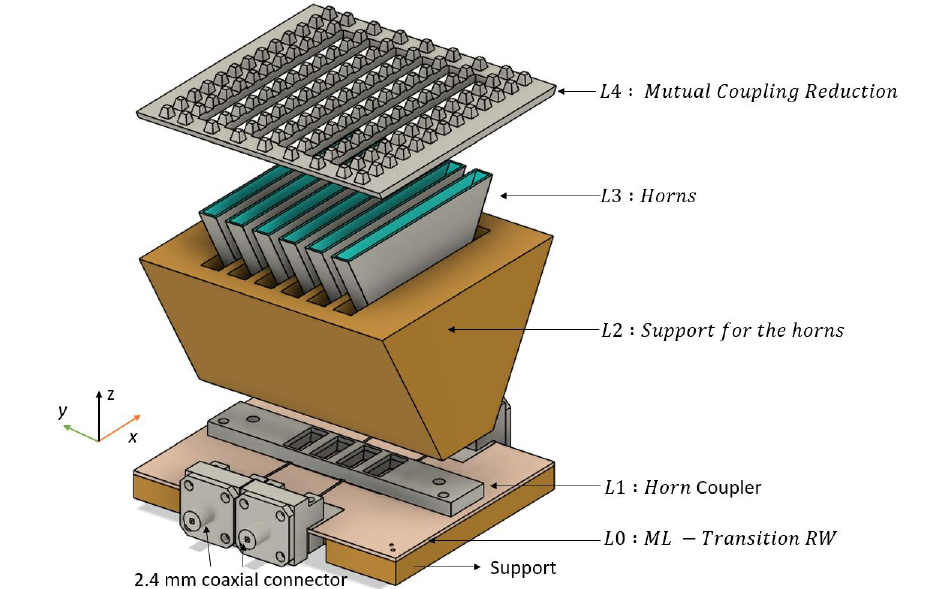
Figure 4. Exploded view of the whole